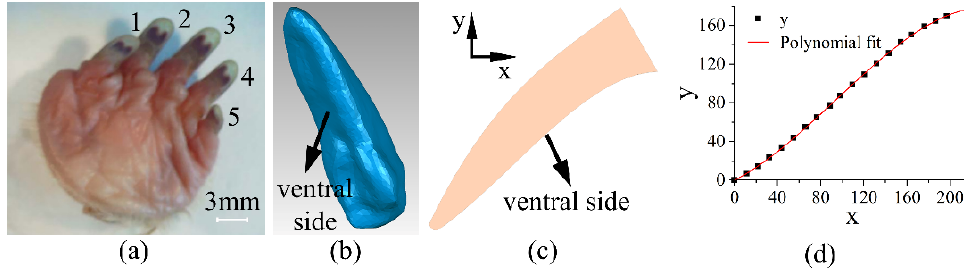
Figure 1. Mole rat’s paws. ( a ) Ventral side of the left front paw [26], ( b ) 3D model, ( c ) the perpendicular bisector plane, and ( d ) the extracted coordinates and its fitting curve of the No. 4 digit of mole rat’s claw.